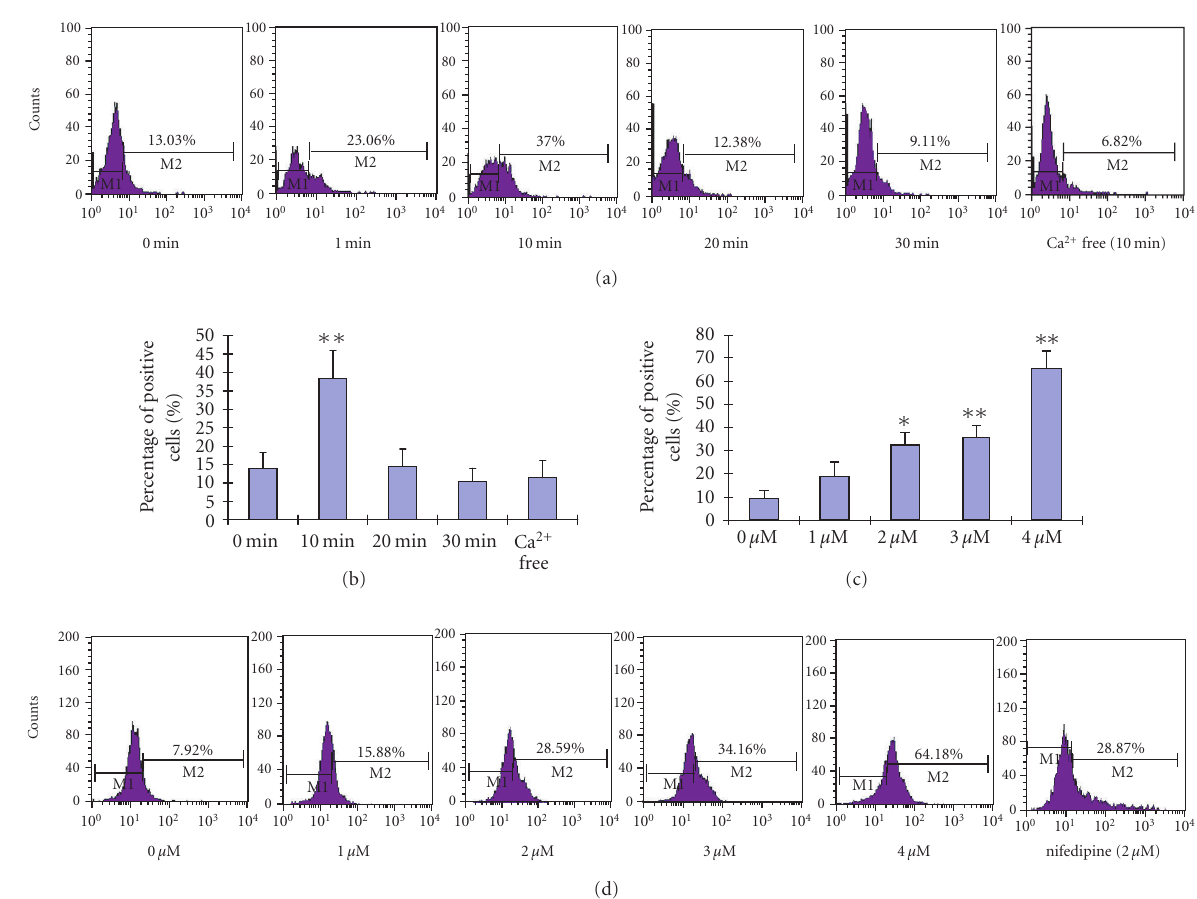
Figure 2: Thapsigargin stimulated ROS production. (a), (b) Flow cytometry profiles showing the time course of ROS production follow- ing stimulation with thapsigargin. RAW246.7 cells were subjected to thapsigargin (2 μ M). ROS were measured by a flow cytometry. ROS production was suppressed in the absence of external Ca 2+ over 10 minutes. (c), (d) Thapsigargin increased the production of ROS in a dose-dependent manner in the presence of external Ca 2+ (at 10 minutes). Three independent experiments have been performed. (cid:0) P < . 05 versus control group; (cid:0)(cid:0) P < . 01 versus control group.